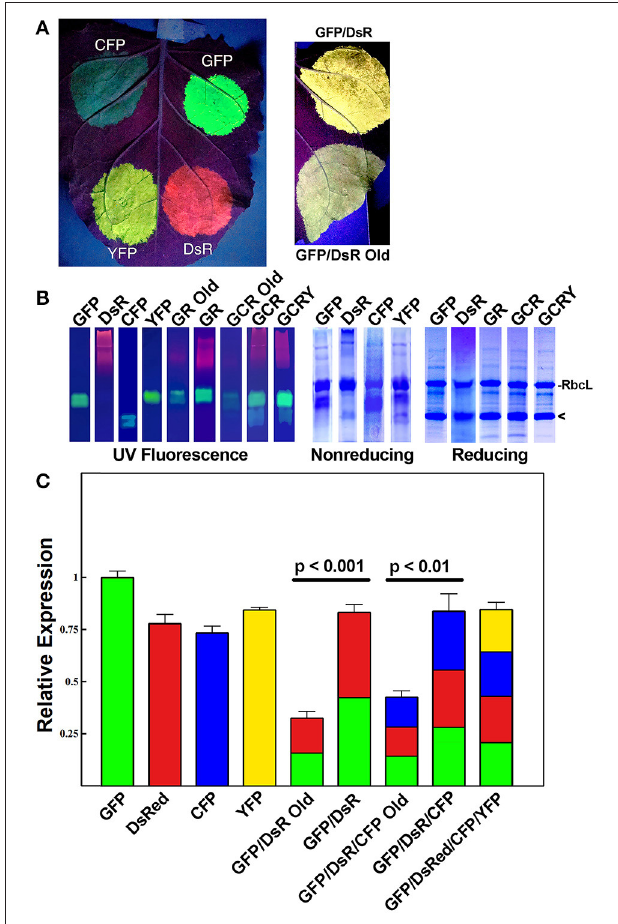
FIGURE 2 | Simultaneous co-expression of up to four proteins with comparisons of optimized BeYDV vectors to unoptimized BeYDV vectors. Leaves of N. benthamiana were agroinfiltrated with either optimized (pBYKEAM or pBYKEAM2) vectors or unoptimized vectors (pBY-GR, pBY-GCR, referred to as “old”) for GFP, DsRed, CFP, and YFP in various combinations and (A) imaged at 5 dpi under UV illumination; or (B) separated by non-reducing or reducing SDS-PAGE and either viewed under UV transillumination or stained with Coomassie gel. Rubisco large subunit (RbcL) and the monomeric-sized band of all fluorescent proteins are indicated. (C) The relative total expression of each combination of constructs was analyzed using ImageJ software to quantify the band intensity of SDS-PAGE reducing gels. The mean band intensity is given ± standard error from 3 independently infiltrated leaf samples, where the expression of pBYKEAM-GFP was arbitrarily defined as 1. The bar colors are estimates of the relative production of each construct by non-reducing SDS-PAGE followed by ImageJ analysis using 3 independently infiltrated leaf samples. Statistical significance was calculated using student’s t